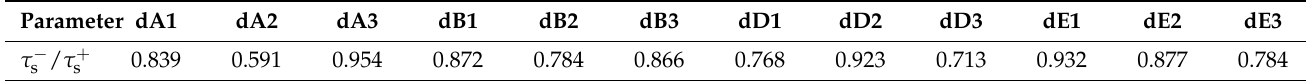
Table 3. Ratio of negative peak bond stress to positive peak bond stress.